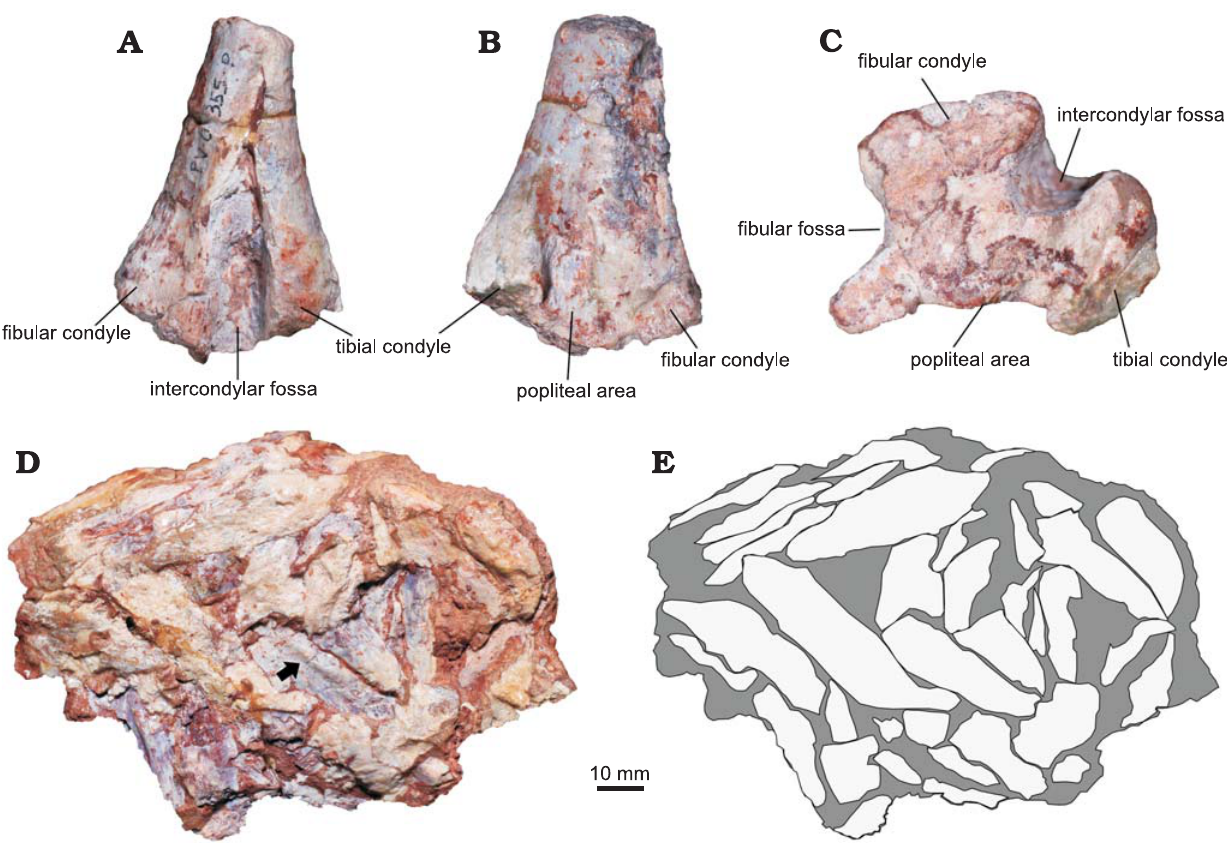
Fig. 6. Postcranial elements of stereospondylomorph temnospondyl Parapytanga catarinensis gen. et sp. nov. (holotype, UFRGS-PV-0355-P) from the Santa Catarina State (Brazil), Middle–Upper Permian. Photos of the right femur in dorsal ( A ), ventral ( B ), and distal ( C ) views. Photo ( D ) and interpreta- tive drawing ( E ) of the ventral scutes. The arrow indicates the internal articular process of a